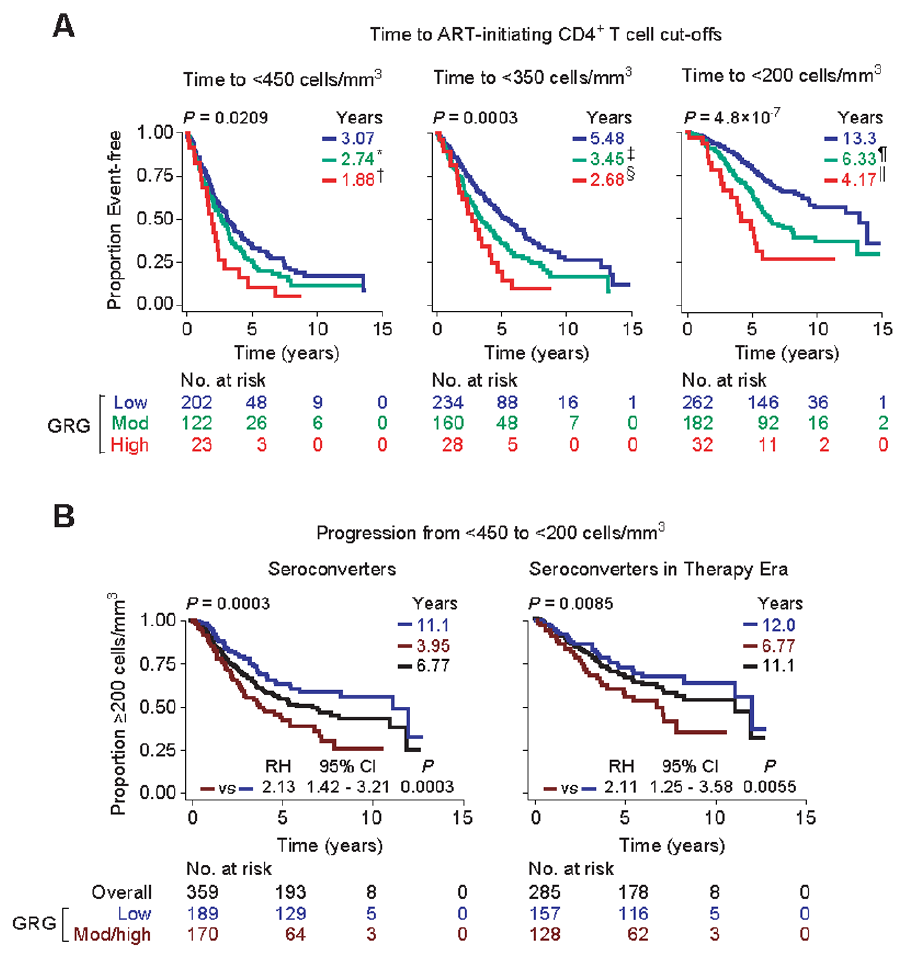
Figure 3. CCL3L1-CCR5 GRGs influence median time-from-seroconversion to CD4 cell count thresholds that might be used to guide initiation of HAART, and time from a high to a low CD4 cell count. In Panel A, KM plots show the time-from-seroconversion to arrival at , 450 (left), , 350 (center) or , 200 (right) CD-cells/mm 3 . In Panel B, the KM plots are for progression from , 450 to , 200 CD4-cells/mm 3 in all seroconverters (left) or seroconverters recruited and followed during the years 1990 to 1999, a time-period in which antiretroviral therapy was available (right). The color codes for the KM plots in panel B are: blue, low GRG; brown, moderate and high GRGs combined into a single category; and black, all subjects. Overall P values are at the top of each plot. Color-coded numbers at the upper right of the KM plots represent the median time-to-event, that is, from seroconversion to the indicated CD4 cell count. In panel A, P values for differences in median time-to-event relative to those with a low GRG were: * , 0.1131; { , 0.0089; { , 0.0030; 1 , 0.0005; " , 0.0001; and I , 9.6 6 10 2 7 . RH, relative hazard; CI, confidence interval. P values in Panel B are adjusted for the steady-state viral load, baseline CD4 and best DTH response recorded during disease course, and subjects with a moderate or high GRG were combined into a single